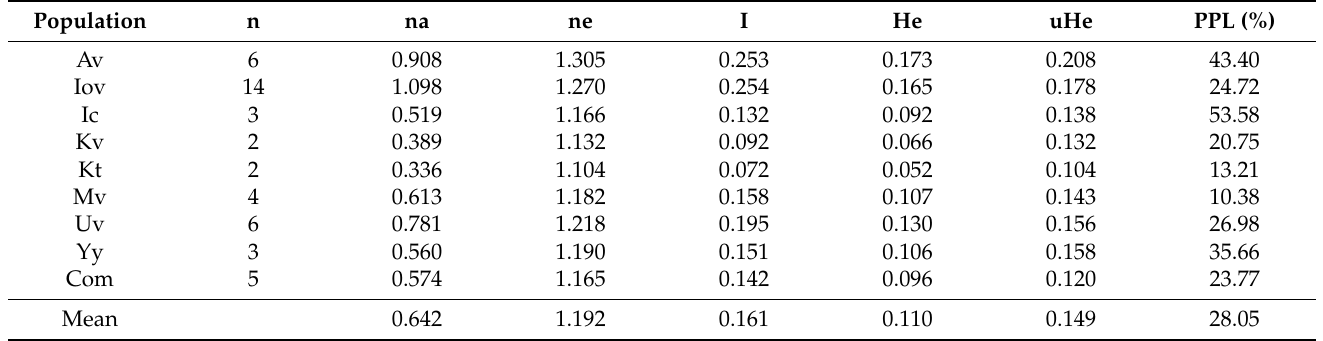
Table 5. Summary statistics for 45 bean ( P. vulgaris L.) varieties assessed with 26 iPBS primers.